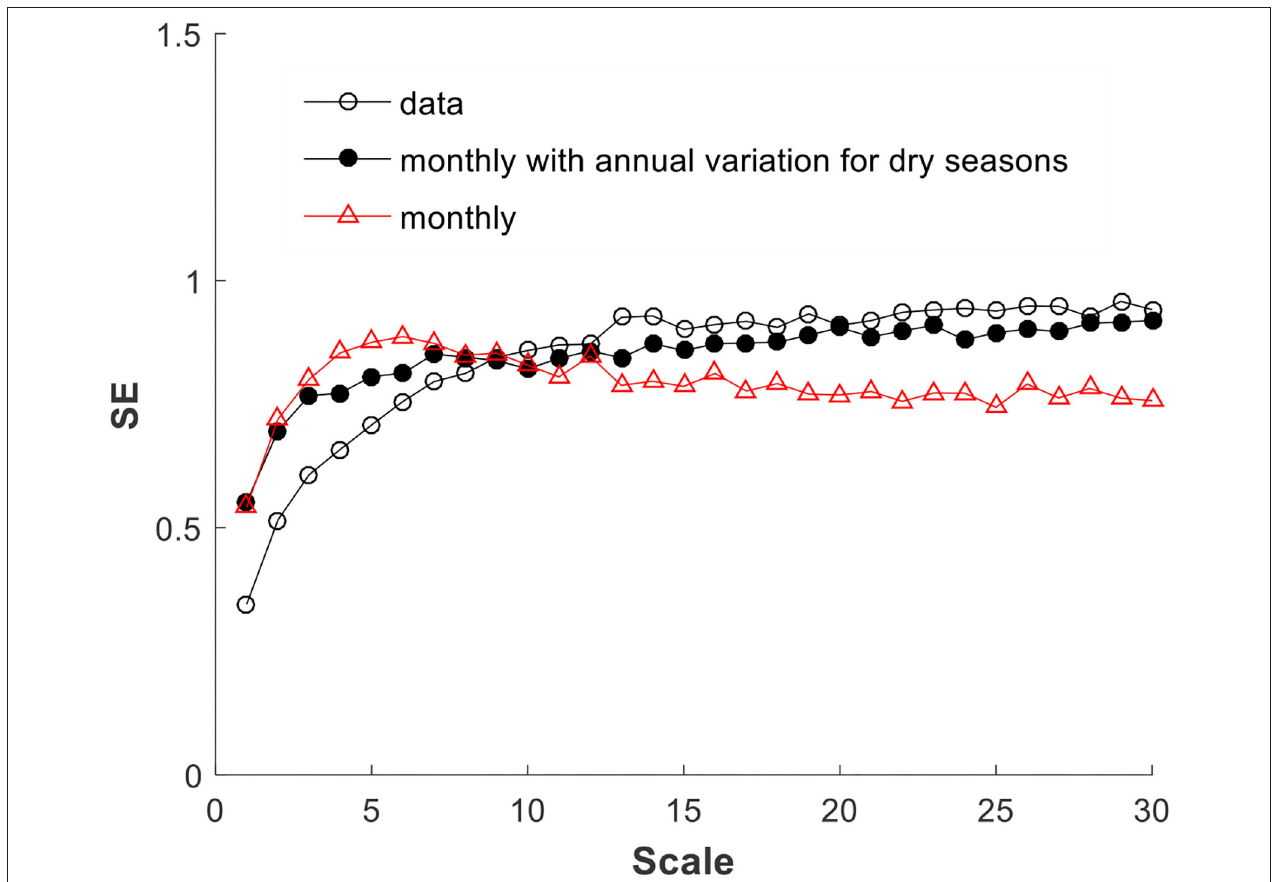
FIGURE 10 | Real data MSE is better matched after introducing into simulation inter-annual variation of the precipitation in dry season.